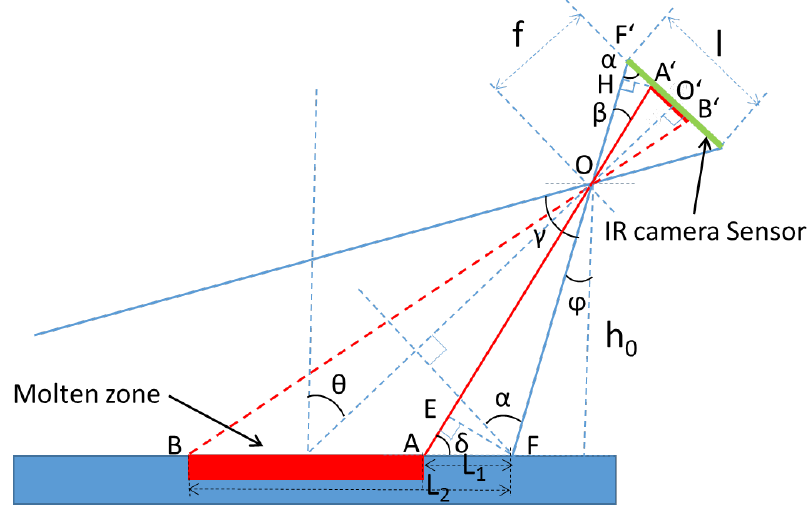
Figure 6. Geometrical illustration of the conversion of zone length distance from pixels to millimeters.